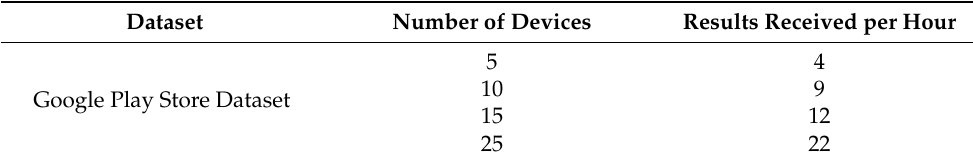
Table 4. Number of results per hour.